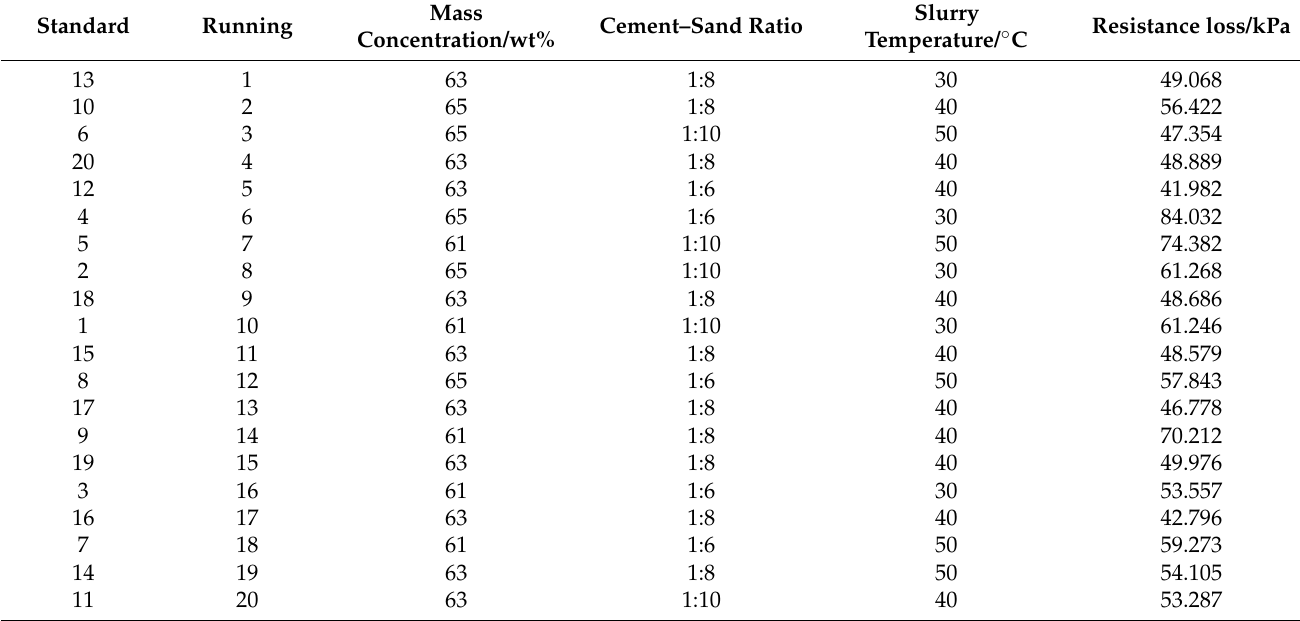
Table 7. Response surface test results of endogenous factors effect.